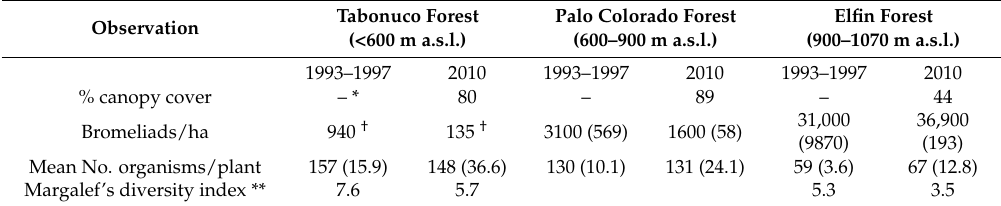
Table 1. Canopy cover, bromeliad density, and animal abundance and diversity in Luquillo Experimental Forest (LEF) bromeliads at two different times. SE in parentheses.